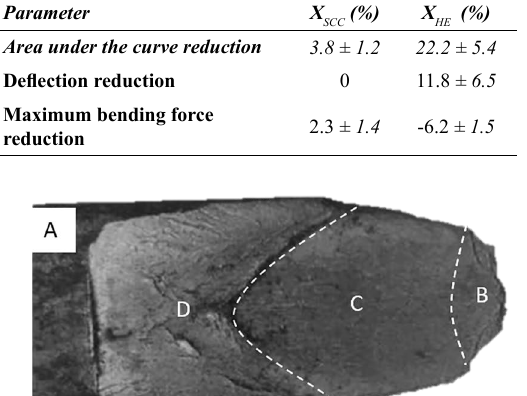
Table 3. Area under load vs deflection curve reduction, deflection reduction and maximum bending force reduction for pearlitic-ferritic material with (X ) and without cathodic protection (X HE